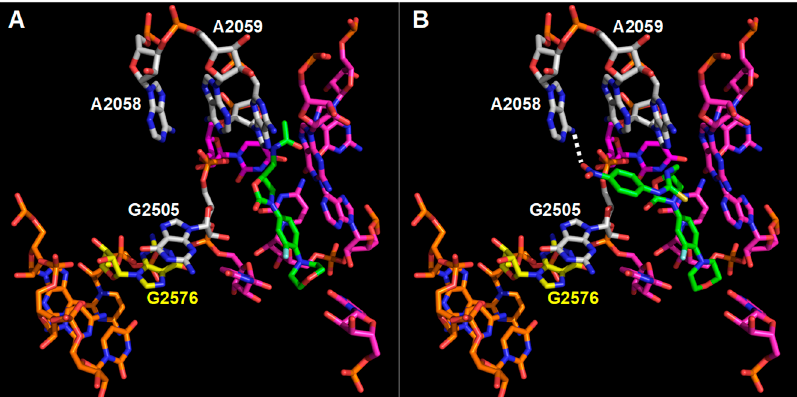
Figure 2. Comparison between the orientations of linezolid and 10f in the large subunit of S. aureus ribosome. ( A ) Linezolid binding pocket in the crystal structure of the ribosome/linezolid complex (PDB code 4WFA). ( B ) Model of the complex 10f/large ribosomal subunit. Linezolid, 10f, and the surrounding nucleotides are shown as sticks. Nitrogen atoms are shown in blue, oxygen in red, fluorine in pale cyan, carbon atoms of linezolid and 10f are in green, carbon atoms of the nucleotides of the linezolid binding pocket are in magenta, carbon atoms of the nucleotides which contact only 10f or make more extended contacts with 10f than with linezolid are in white, carbon atoms of G2576 are in yellow and carbon atoms of its neighbors (C2575, G2578, C2579, and U2580) are in orange. The dashed white line in panel ( B ) indicates the possible H-bond between the nitro group of 10f and the NH 2 group at position 6 of